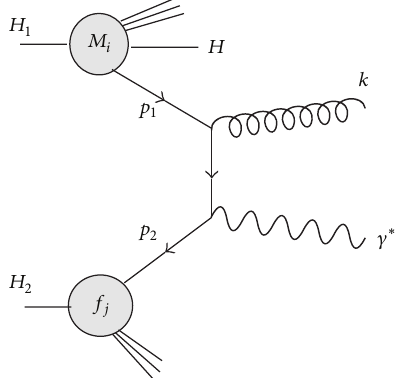
Figure 3: Example of diagram contributing to O (𝛼 𝑠 ) corrections in the target fragmentation region